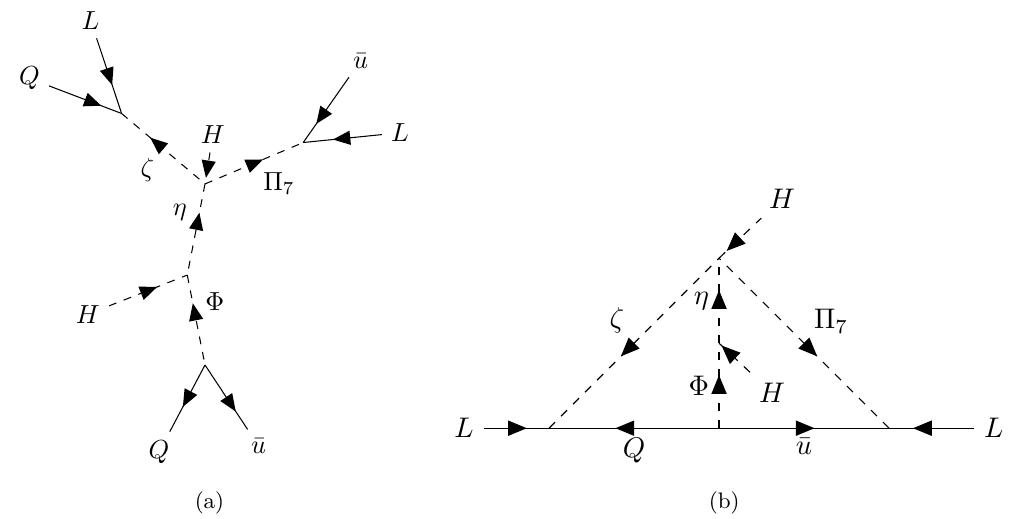
Figure 19. (a) The figure shows the tree-level completion diagram for the model constructed to address the flavour anomalies and neutrino masses. The topology is labelled 2 s 6 f 2 in our scheme. The closure contains two arrow-preserving loops, which arise by looping the ¯ u into the ¯ u † and the Q into the Q † . (b) The self-energy diagram for the same model. The diagram has a CLBZ-10 topology in the language of ref. [27]. The neutrino masses are not suppressed by SM-fermion masses on account of the arrow-preserving fermion lines. This feature raises the bound on the new-physics scale relevant to the model, but also allows couplings to the second generation of fermions to play a role in the physics of neutrino mass. This is beneficial in our case since many of these couplings are involved in generating the pattern of dimension-six operators that motivates this example, and so provides for a more intimate connection between the flavour anomalies and neutrino